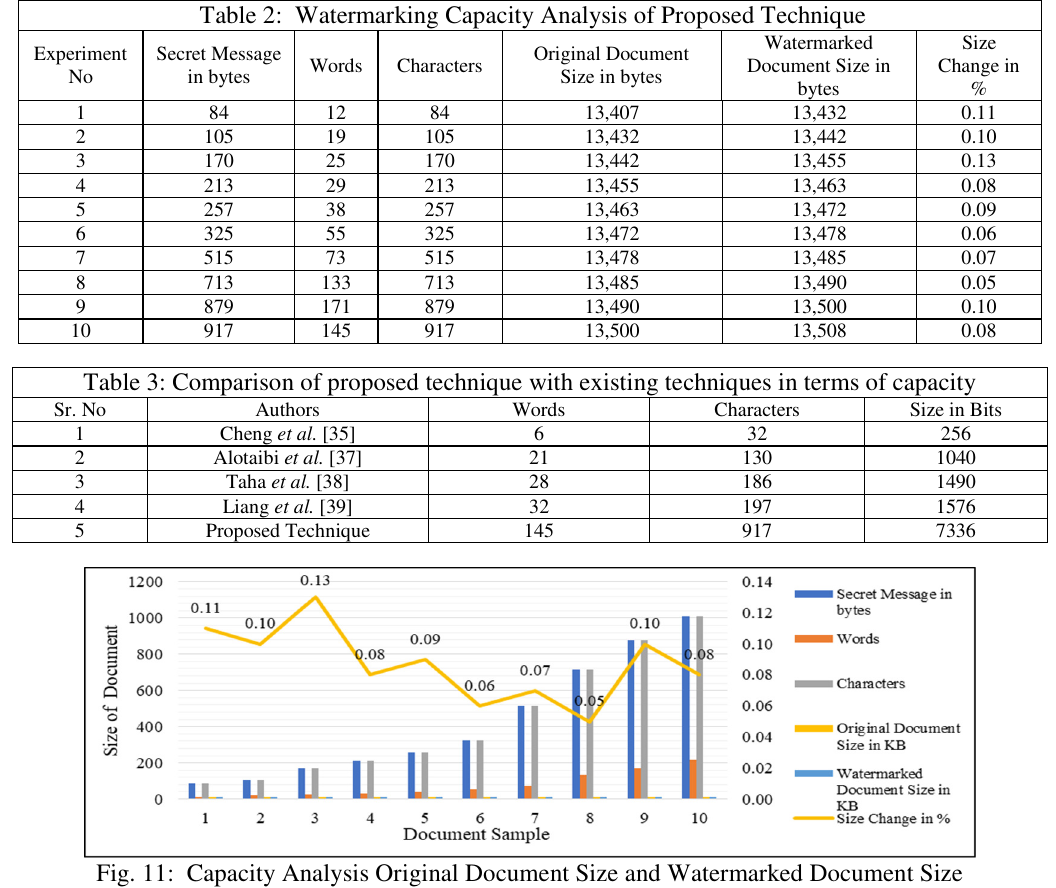
Table 2: Watermarking Capacity Analysis of Proposed Technique